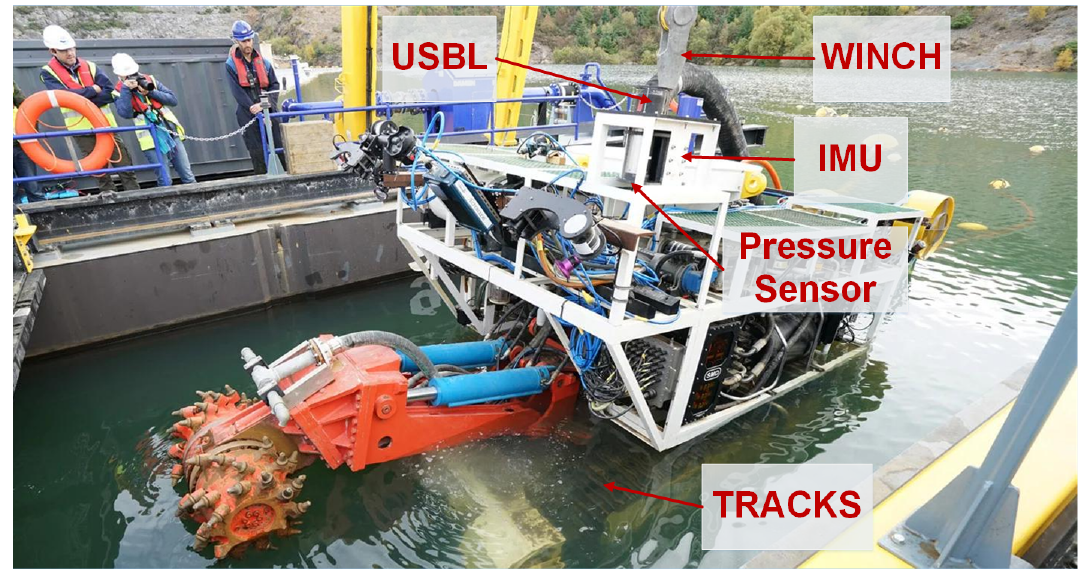
Figure 3. Localization sensors installed on board the mining